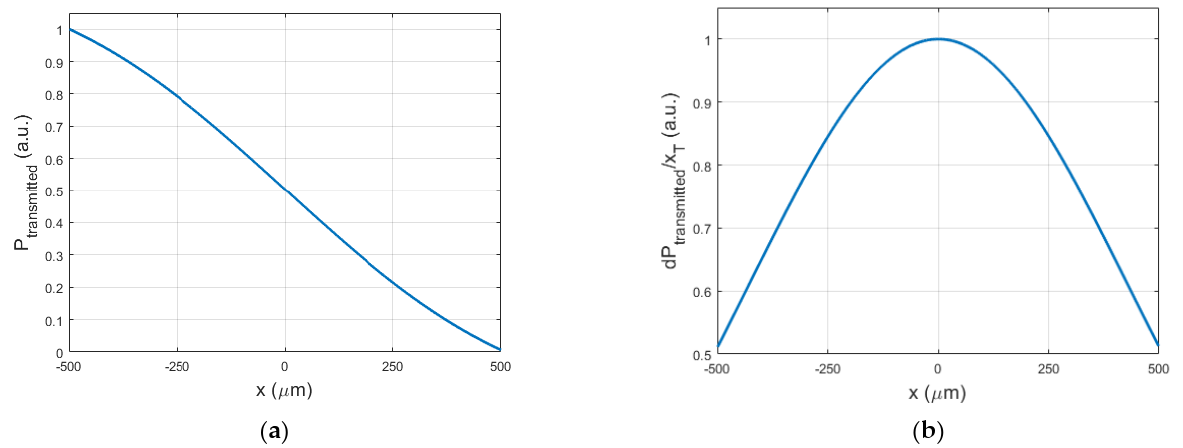
Figure 8. ( a ) Transmitted light power P transmitted at z = 1 mm when the rectangular sheet blocks the airgap as a function of the radial beam coordinate x. ( b ) Spatial (x-) derivative of P transmitted (x) 1 mm.